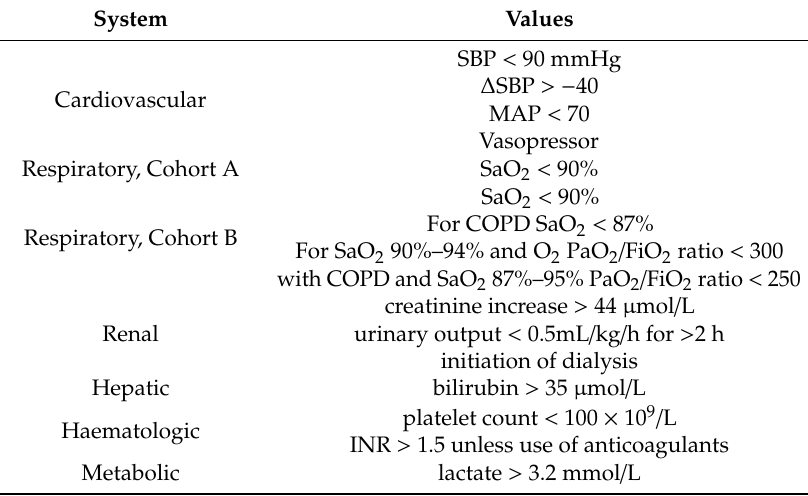
Table 1. Organ dysfunction